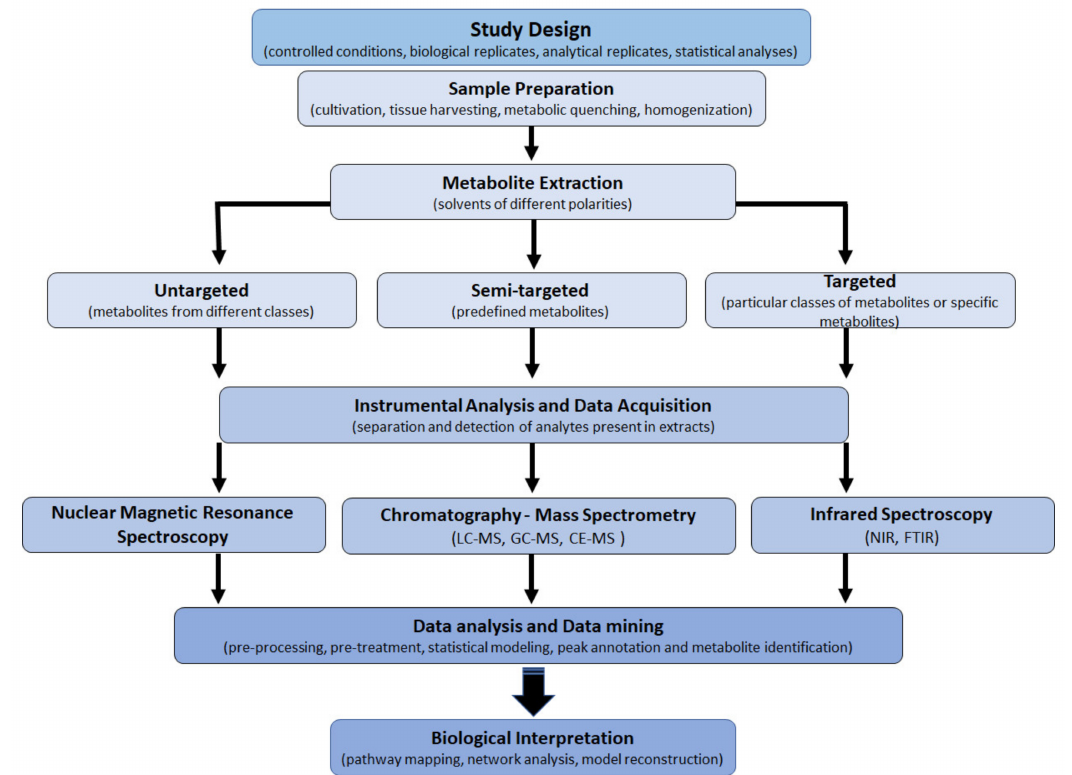
Figure 3. Basic multi-step workflow of plant metabolomics: sample preparation, data acquisition, and data analysis form the backbone of metabolomic analysis. Analytical platforms include liquid – or gas chromatography coupled to mass spectrometery (LC / GC-MS), capillary electrophoresis coupled to MS (CE-MS), nuclear magnetic resonance (NMR) spectroscopy, and near-infrared (NIR) and